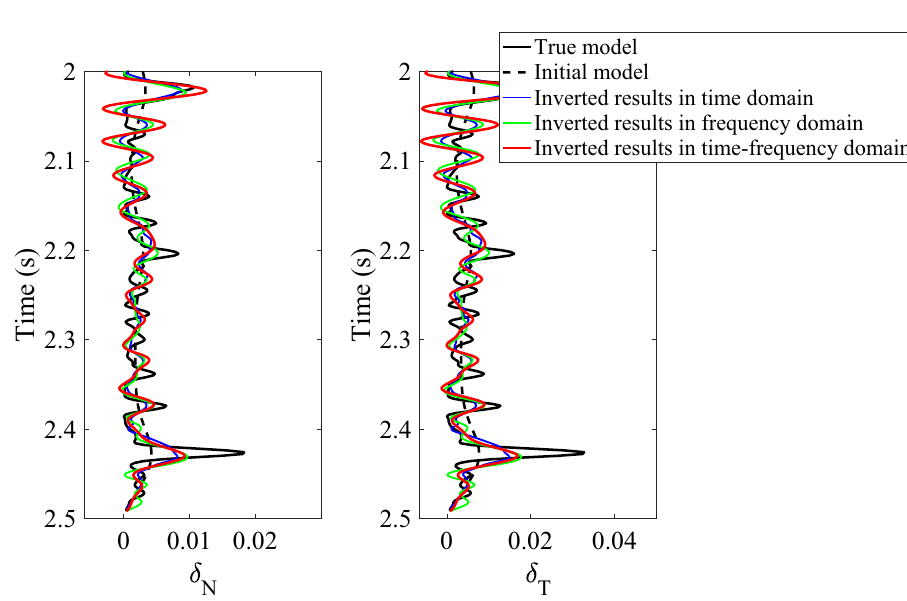
Figure 11. Comparison between inversion results of normal and shear fracture weaknesses in different domain at the well